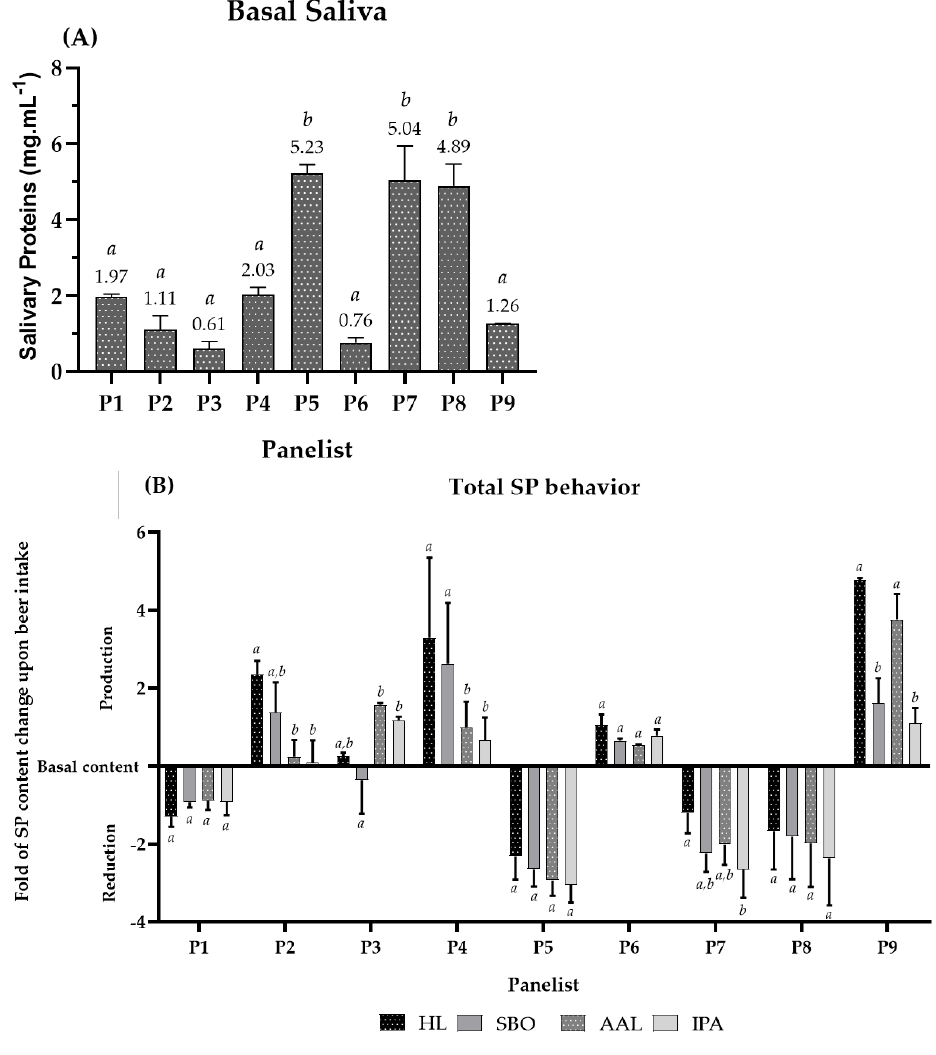
Figure 1. ( A ) Total concentration of soluble SP in basal saliva for each panelist. ( B ) SP behavior after intake of each beer, where Coruja Hoppy Lager (HL), Super Bock Original (SBO), Coruja American Amber Lager (AAL), and Coruja India Pale Ale (IPA), respectively. The SP behavior is presented by the fold of total soluble SP, for each panelist, during beer sensorial analysis. Fold represents how many times SP reduction or production occurs regarding the previous beer intake of saliva collection for each panelist. Values with different letters within each panelist are significantly different ( p < 0.05).